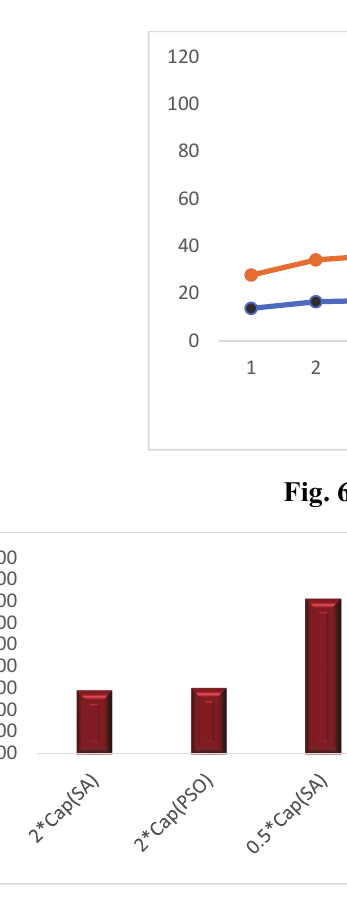
Fig. 7. Impacts of Vehicles Capacity on OFV Fig. 8. Impacts of Traffic time on OFV (20*4)